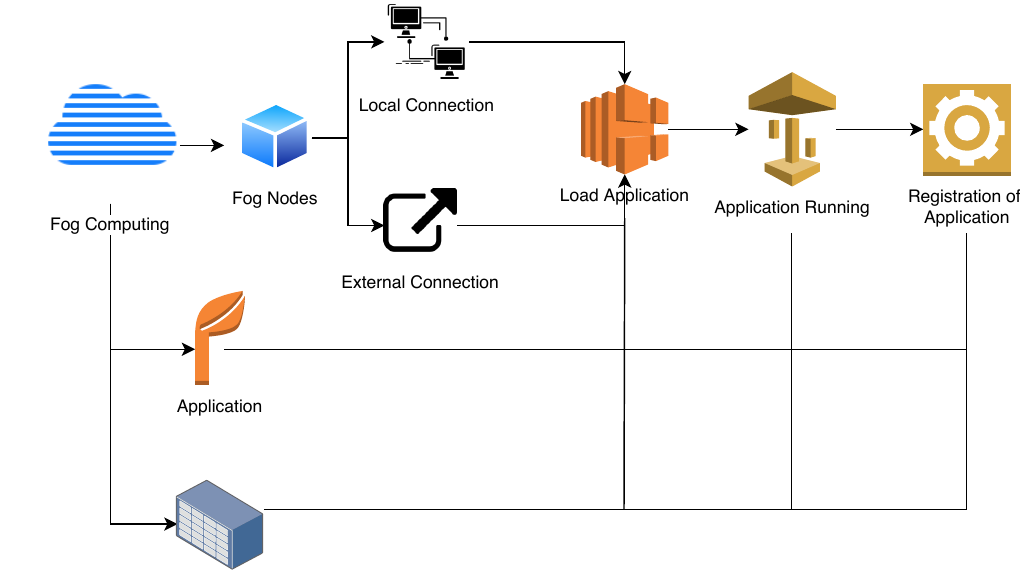
Figure 3. Model diagram of proposed BFAN